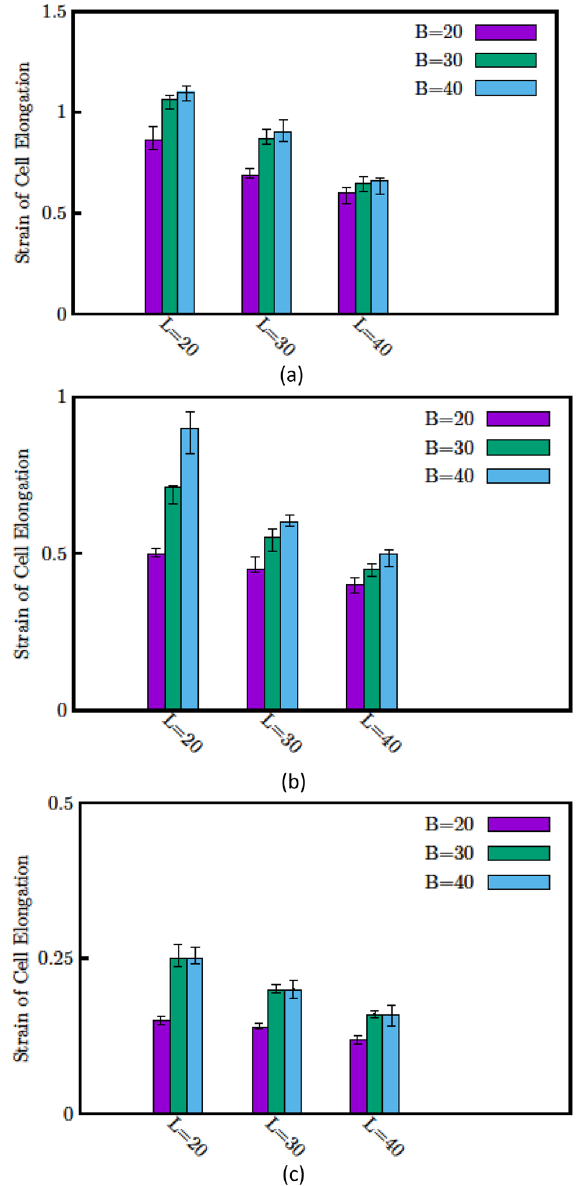
Figure 8. Normalize elongation ( L ∗ ) of ( a ) Erythrocyte ( b ) PBMC ( c ) T-47D is shown for different sizes of electrodes. In each figure, the normalized elongation for three width and three gap sizes of electrodes (all units are